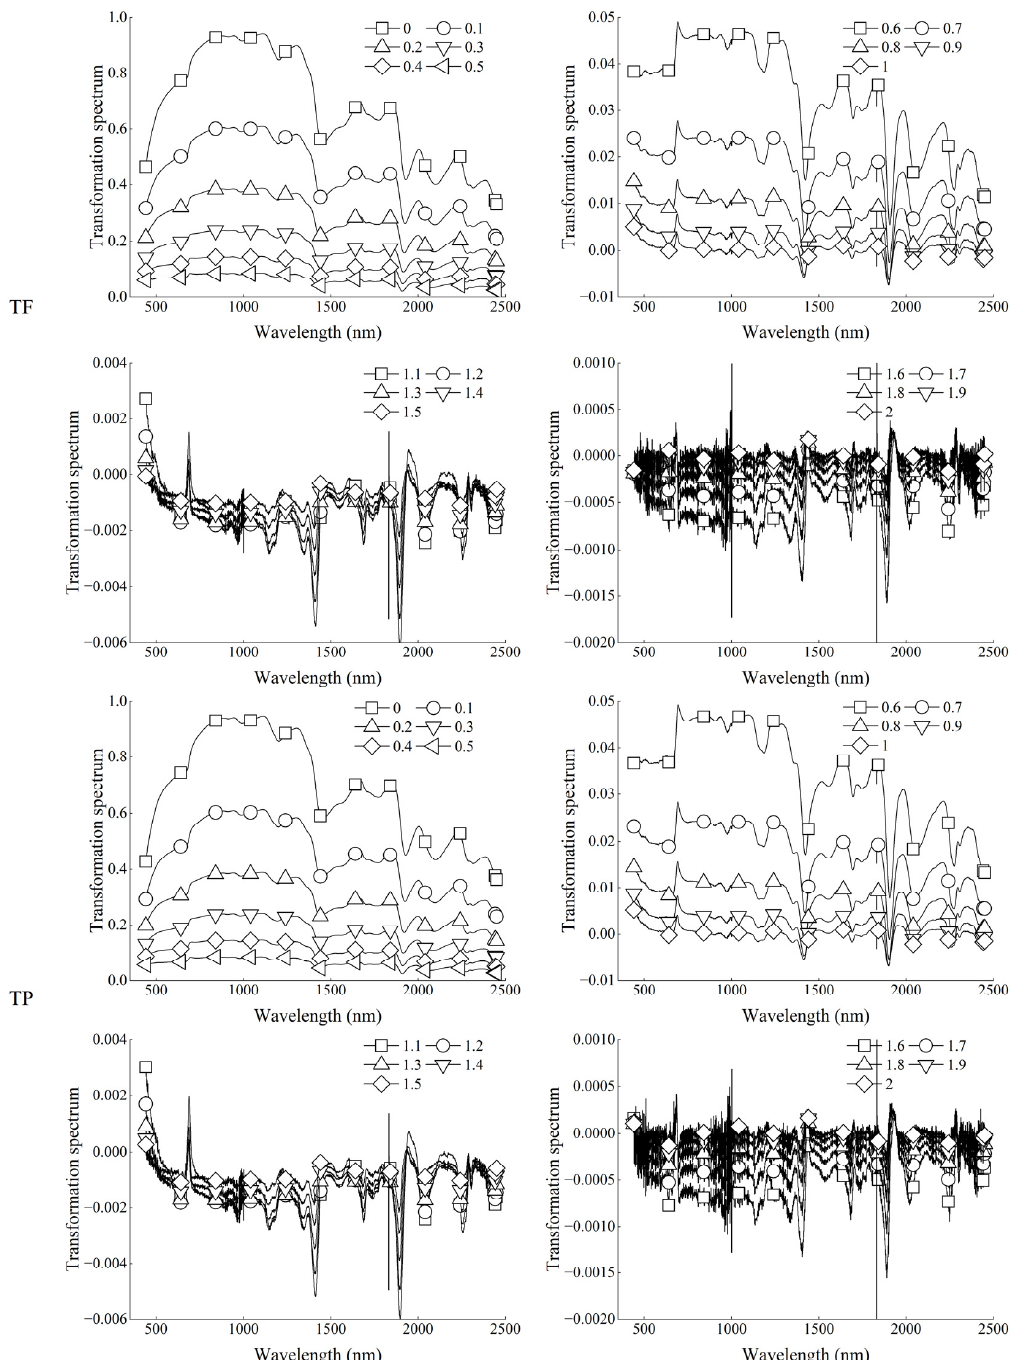
Figure 4. Spectral re fl ectance after FOD preprocessing.